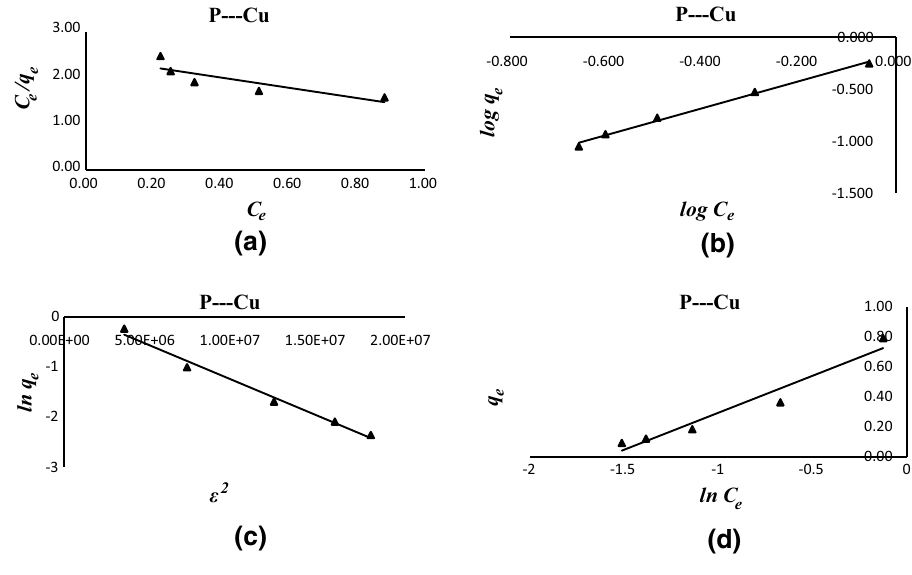
Fig. 2 Adsorption equilibrium isotherms: a Langmuir, b Fre- undlich, c D-R, d Temkin